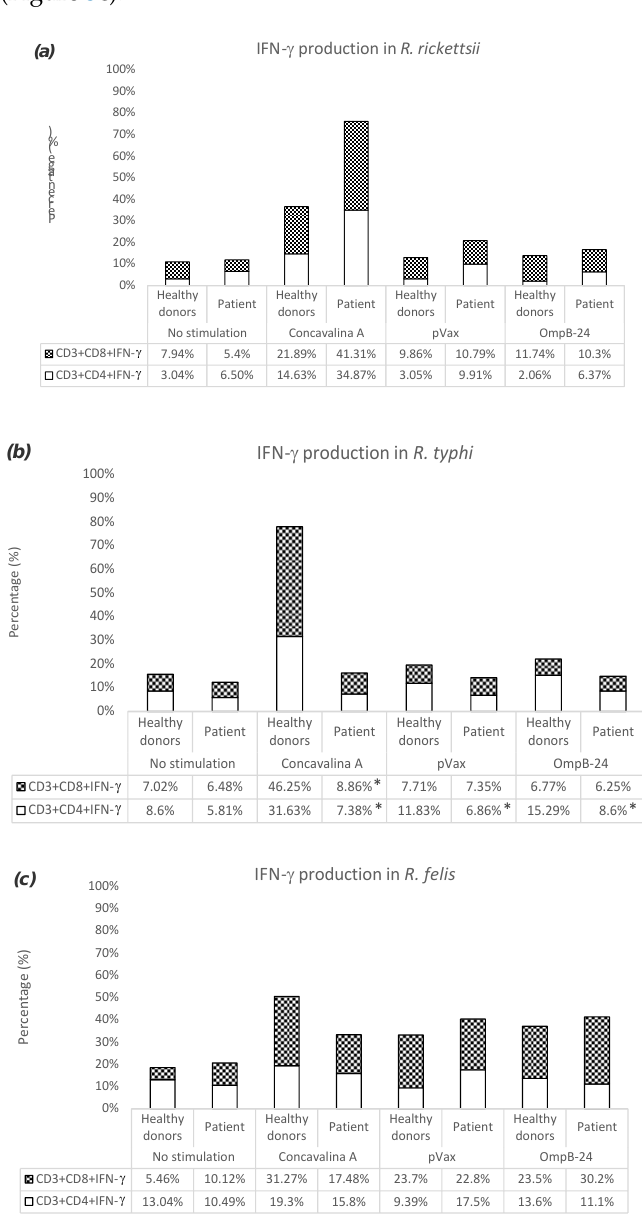
Figure 3. Population of T lymphocytes producing INF- γ . Percentage of TCD4+INF- γ + and TCD8+INF- γ + in healthy donors and patients post-infection with R. rickettsii ( a ), R. typhi ( b ) and R. felis ( c ), stimulated or not with ConA, pVax and OmpB -24 for 24 h. Values show the average of 5 samples. (*) p -value ≤ 0.05 calculated with the Student’s t -test. When determining the antigenic presentation of transfected macrophages, higher percentages of CD40+, CD80+, HLA-I and HLA-II were observed in macrophages from healthy donors transfected with the OmpB-24 plasmid compared to those from patients infected with R. felis, R. typhi, and R. rickettsii . (Table 2). However, when evaluating the MFI (Mediam Fluorescence Intensity) in the group of patients with R. felis , a higher ex- pression of CD40+, CD80+, HLA-I and HLA-II was observed compared with the controls (Table 3). Macrophages from patients stimulated with OmpB-24 showed a low percentage compared to healthy subjects, but had a higher IMF.